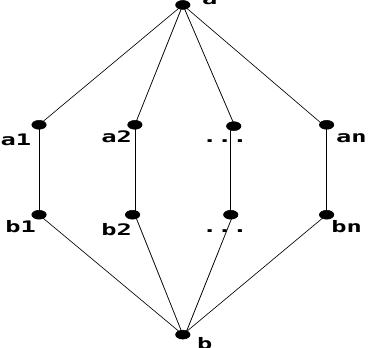
} × { a } × : : : × { a ; b ; b 1 1 2 2